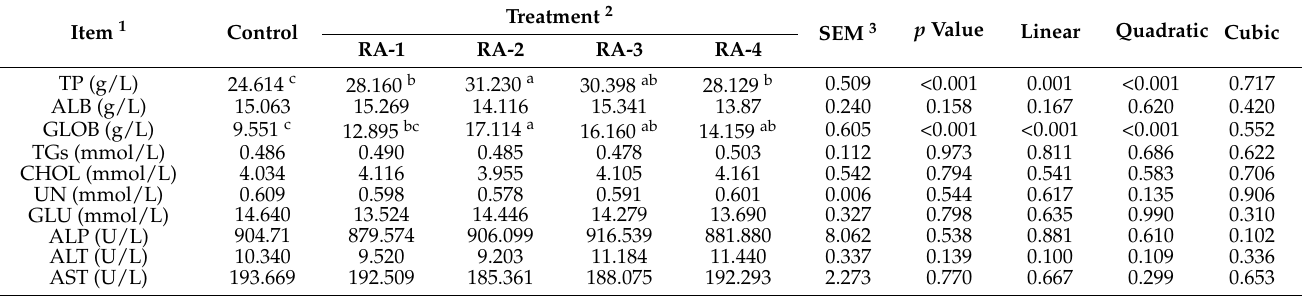
Table 3. The effect of dietary supplementation with rosmarinic acid (RA) on serum biochemical indices of